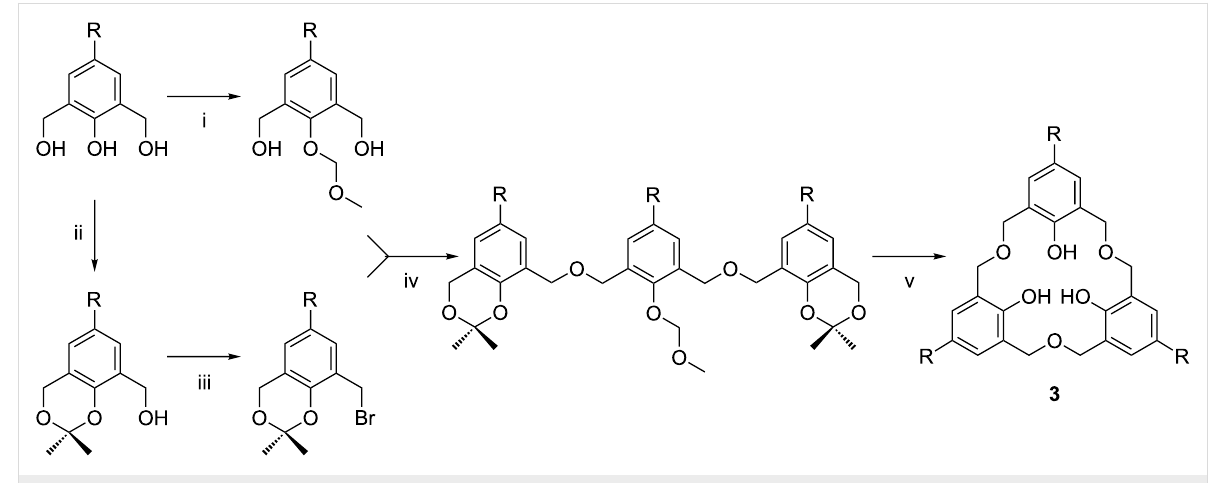
tion. Coupling reactions are successful, whether the groups in the para -position are the same or different, and this method also gives access to oxacalix[4]arenes in modest yields up to 42% for the p - tert -butyl